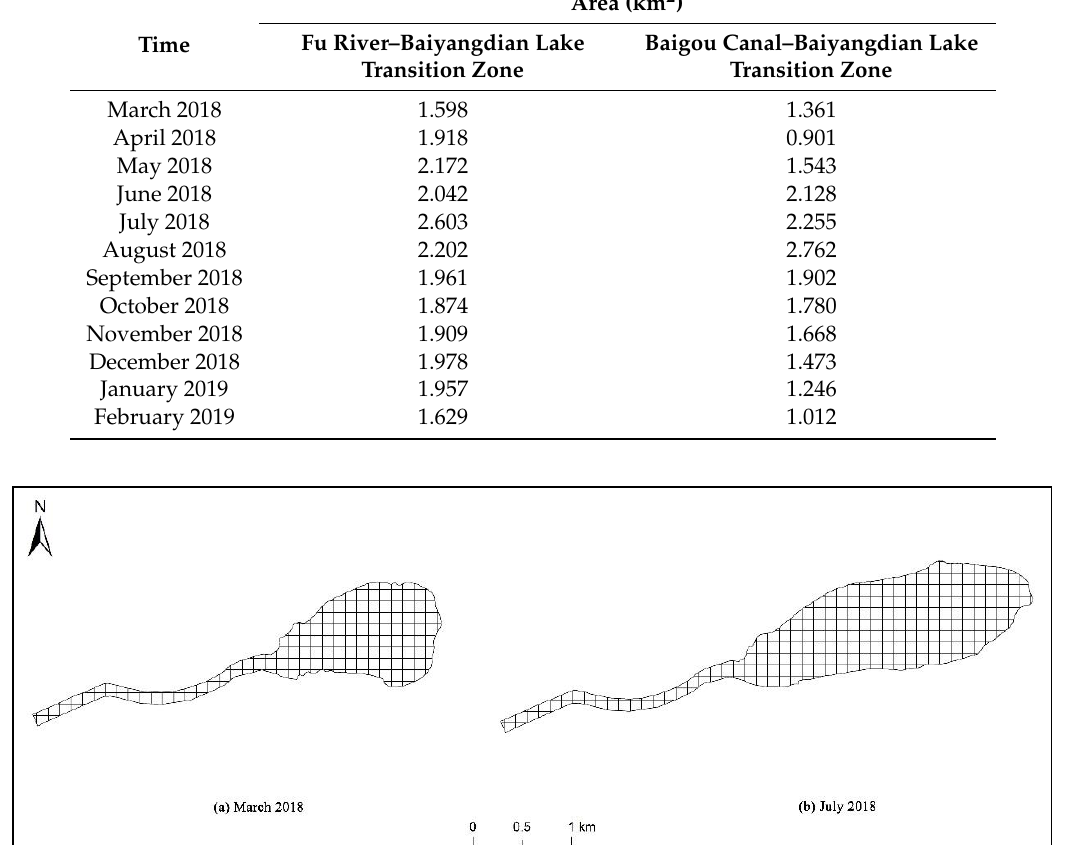
Figure 13. Area of the Fu River–Baiyangdian Lake transition zone. ( a ) March 2018, when the area was smallest, and ( b ) July 2018, when the area was largest. Charts for the area in other months are shown in Appendix B Figure A3. Numeric values of the areas are shown in Table 4.